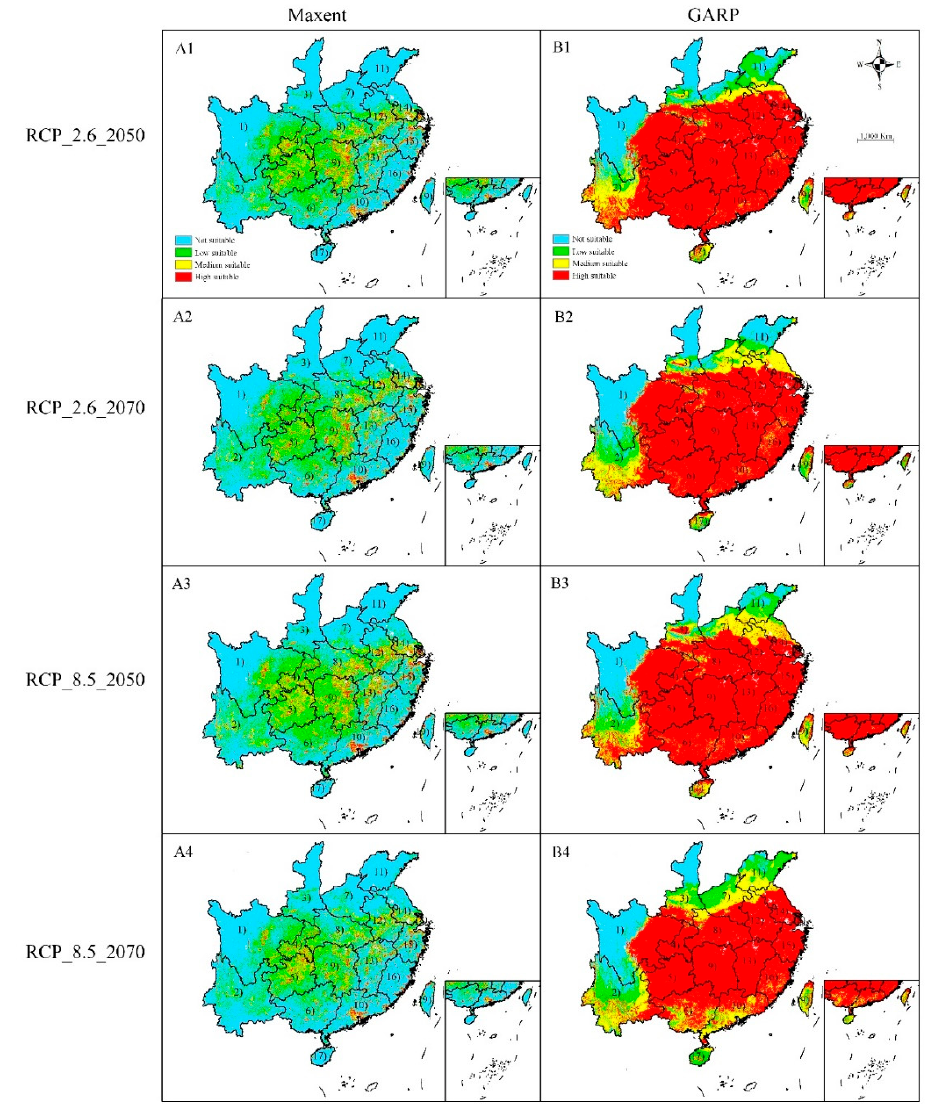
Figure 3. Potential suitable habitat of Cinnamomum camphora predicted by ( A ) Maxent and ( B ) GARP under future climate change scenarios RCP2.6 and RCP8.5. A1, B1—scenarios for RCP 2.6–2050; A2, B2—scenarios for RCP 2.6–2070; A3, B3—scenarios for RCP 8.5–2050; A4, B4—scenarios for RCP 8.5–2070. ( 1 ), Sichuan; ( 2 ), Yunnan; ( 3 ), Shanxi; ( 4 ), Chongqing; ( 5 ), Guizhou; ( 6 ), Guangxi; ( 7 ), Henan; ( 8 ), Hubei; ( 9 ), Hunan; ( 10 ), Guangdong; ( 11 ), Shandong; ( 12 ), Anhui; ( 13 ), Jiangxi; ( 14 ), Jiangsu; ( 15 ), Zhejiang; ( 16 ), Fujian; ( 17 ), Hainan; ( 18 ), Taiwan. Both Maxent and GARP used the same threshold of classi ‐ fication, i.e., high potential (>0.6), moderate potential (0.4–0.6), low potential (0.2–0.4), and not potential (<0.2) habitat. Only the provinces where C. camphora was predicted to occur are shown.